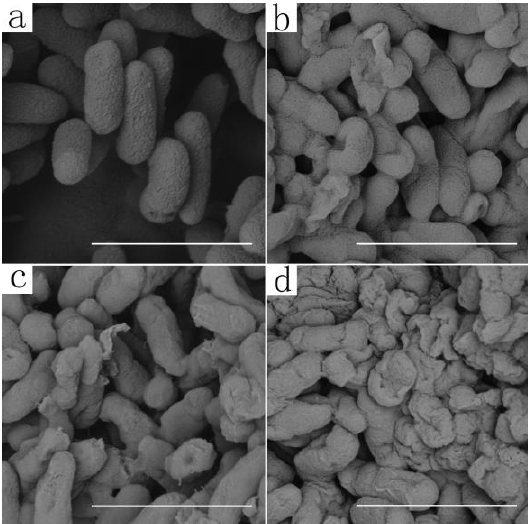
Figure 3. SEM images of Psa after being incubated with different concentrations of ethylicin: ( a ) 0 μg/mL; ( b ) 50 μg/mL; ( c ) 75 μg/mL; and ( d ) 100 μg/mL ethylicin. The scale bars for ( a – d ) are 2 μm.